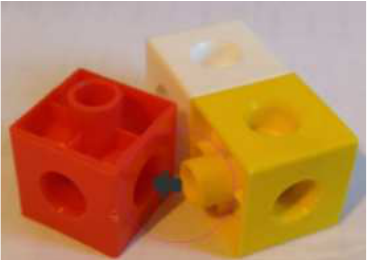
Fig. 3. Emboitements de cubes.